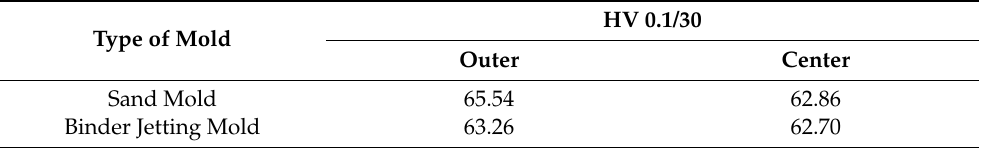
Table 5. Hardness values of casting specimens: binder jetting and sand